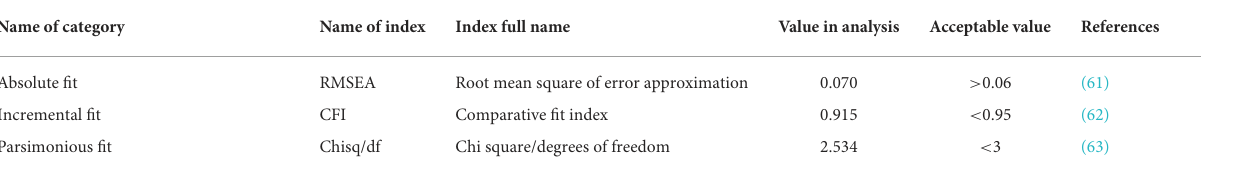
TABLE 2 Pooled CFA model fitness tests. Pooled CFA model fitness